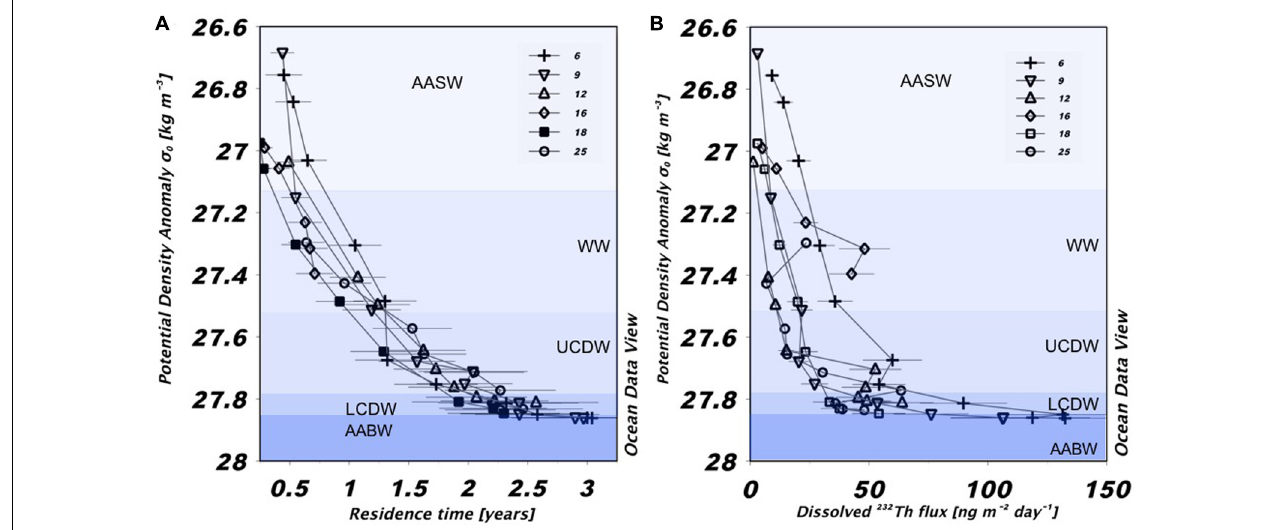
FIGURE 9 | Estimated scavenging residence time (A) and 232 Th flux (B) for the HEOBI stations. Error was propagated considering all parameters used for the calculation and represents around 25%. The deepest sample of each station was collected ∼ 10 m above the seafloor.